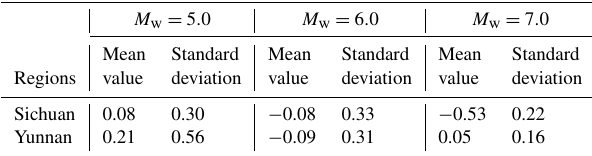
Table 2. Mean value and standard deviation of